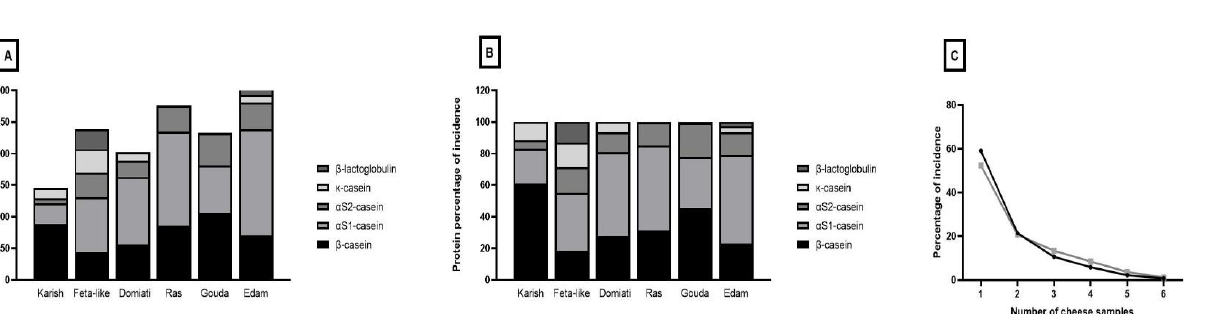
Figure 3. The peptidomics analysis of the cheese low-molecular weight peptide fractions. ( A ) Number of identified peptides divided by protein type. ( B ) Protein percentage distribution of peptides identified in the different cheeses. ( C ) Frequency of distribution of the number of peptides (black line) and of the number of bioactive peptides (grey line) identified in the different cheeses expressed as the percentage of incidence. The complete list of peptides identified in the different cheeses is reported in Supplementary Table S1.